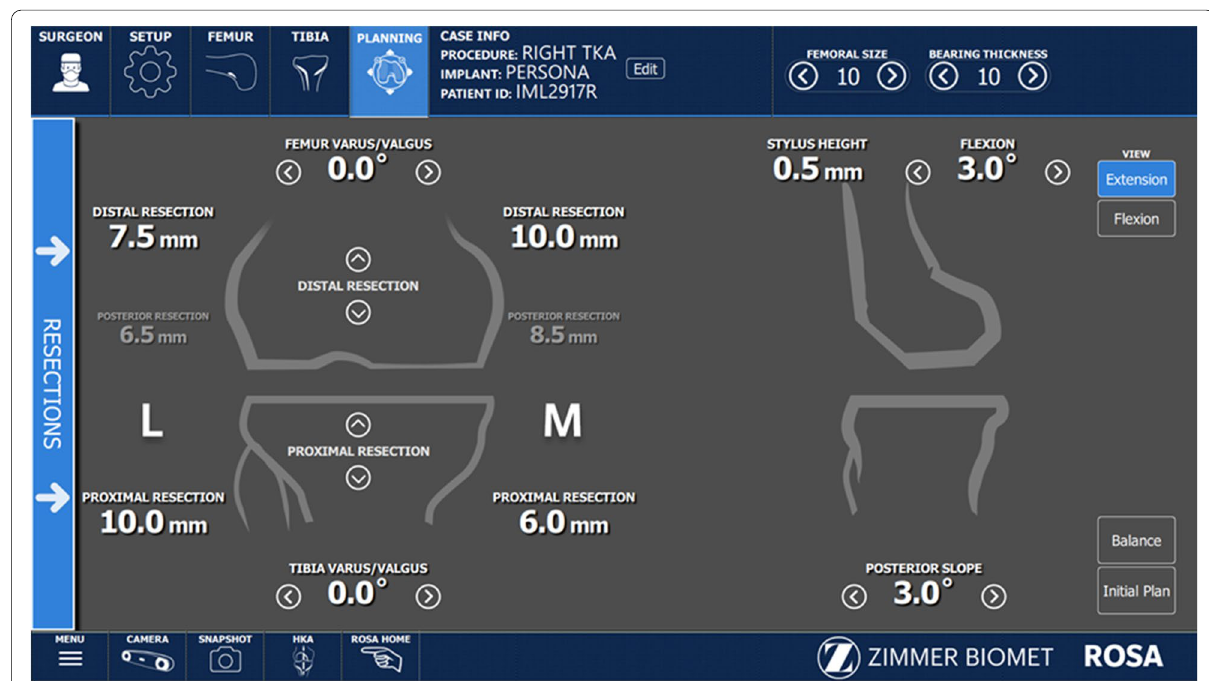
Fig. 2 An intraoperative screen shot from the robotic system demonstrating the surgeon’s ability to plan resection depths and component